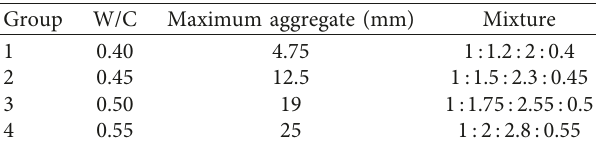
Figure 5: Impact of W/C and aggregate particle size on AE wave velocity with different distances: (a) 100mm and (b) 300mm. Table 2: The ratio of mixture proportion of the material.